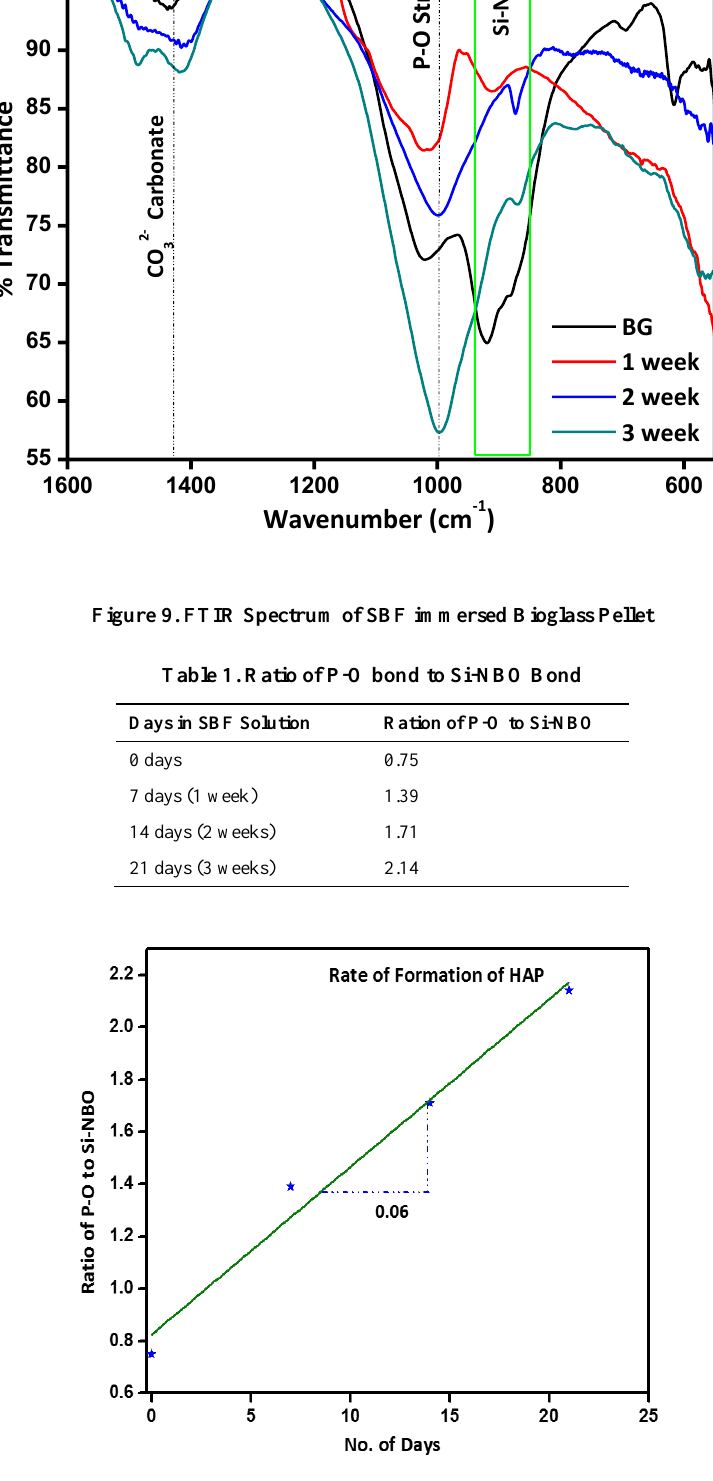
Figure 10. Rate of Apatite